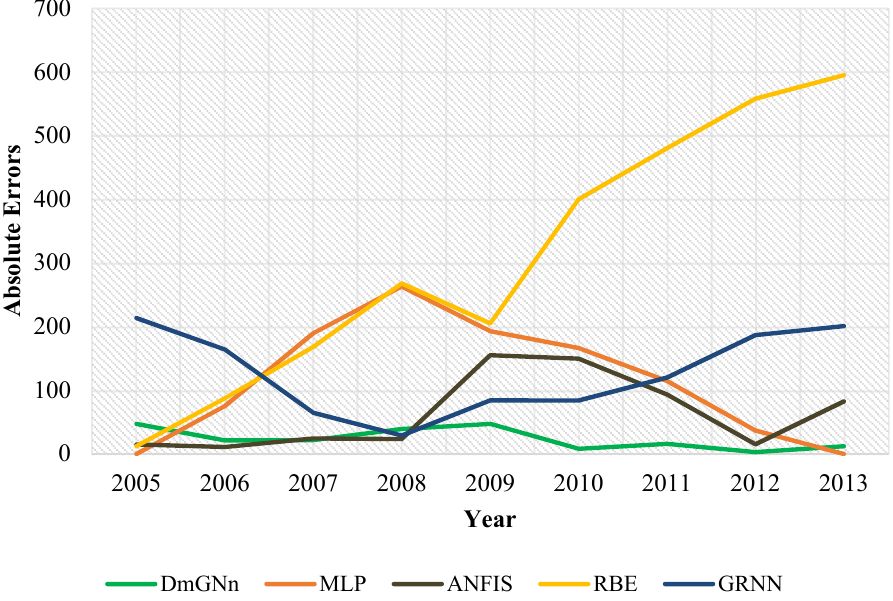
Figure 8. Absolute error for each forecasting model along the testing period.